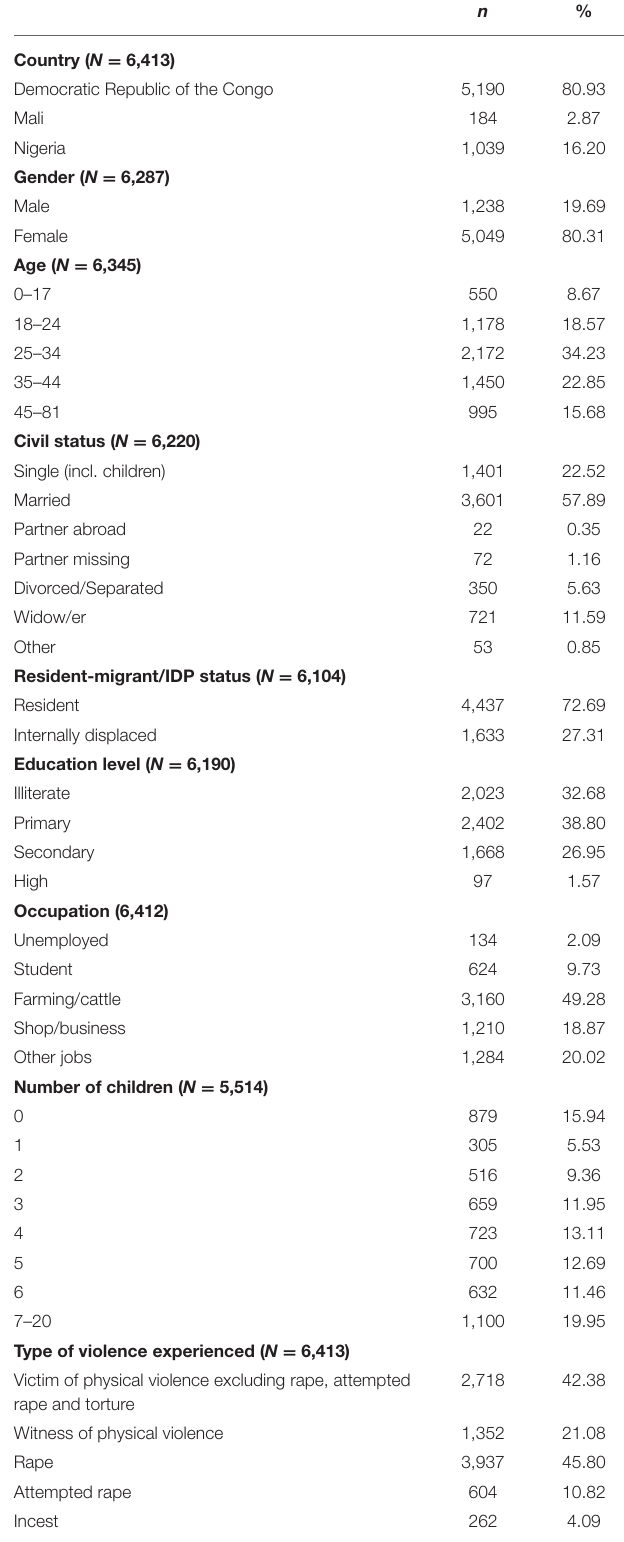
TABLE 1 | Characteristics of the study population and the